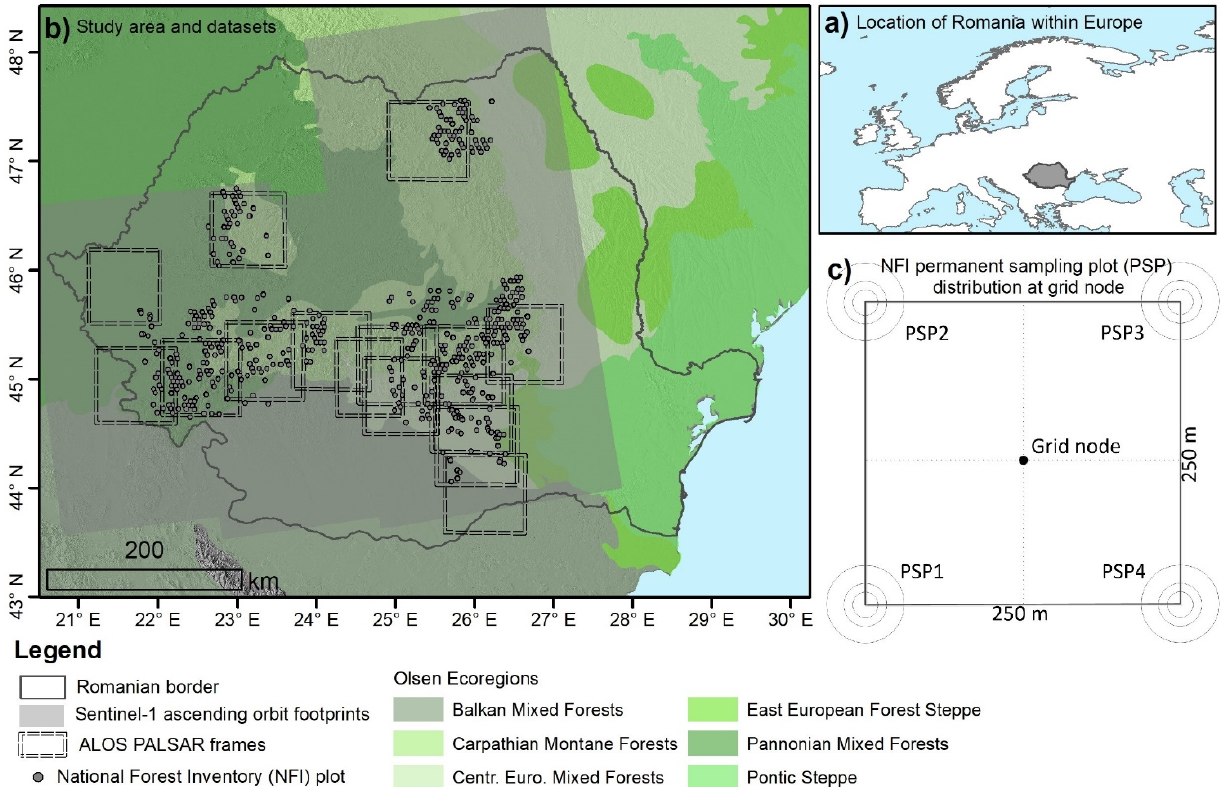
Figure 1. Study area within the Romania borders ( a ) and the locations of the available national forest inventory (NFI) sample plots (b). Detail of NFI node ( c ). Each PSP is formed by concentric circles of 7.98 m, 12.62 m, and 25 m radius.